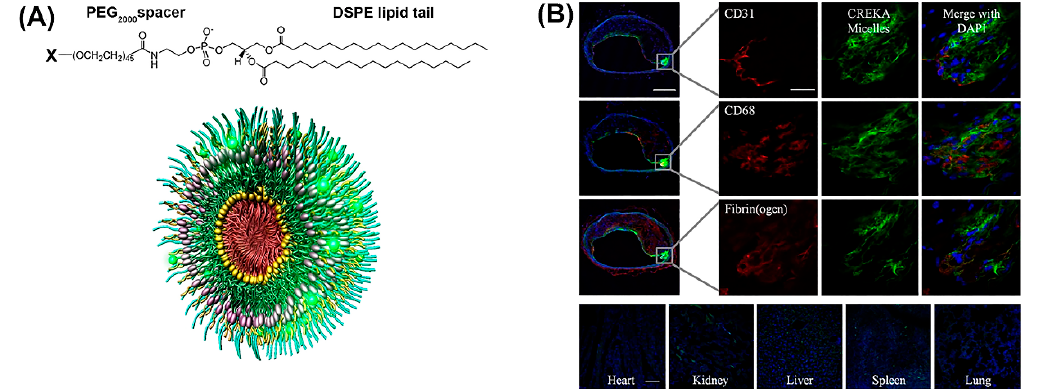
Figure 3. ( A ) Construction of modular multifunctional micelles. Individual lipopeptide monomers are made up of a DSPE tail, PEG 2000 spacer, and a variable polar head group (X) of CREKA, FAM-CREKA, FAM, N -acetylcysteine, Cy7, or hirulog (top). The monomers were combined to form various mixed micelles. The 3D structure of FAM-CREKA/Cy7/hirulog mixed micelles (bottom). ( B ) Fluorescent microscopy images of micelle localization in the atherosclerotic plaque obtained 3 h after tail vein injection of 100 μ L micelles (1 mM) (upper panels). No fluorescence was observed in the heart or lung, and only little fluorescence was observed in the kidney, spleen, and liver (scale bar, 100 μ m) (bottom panels). Adapted and modified from [47], with permission. Copyright: 2009 National Academy of Sciences, USA.